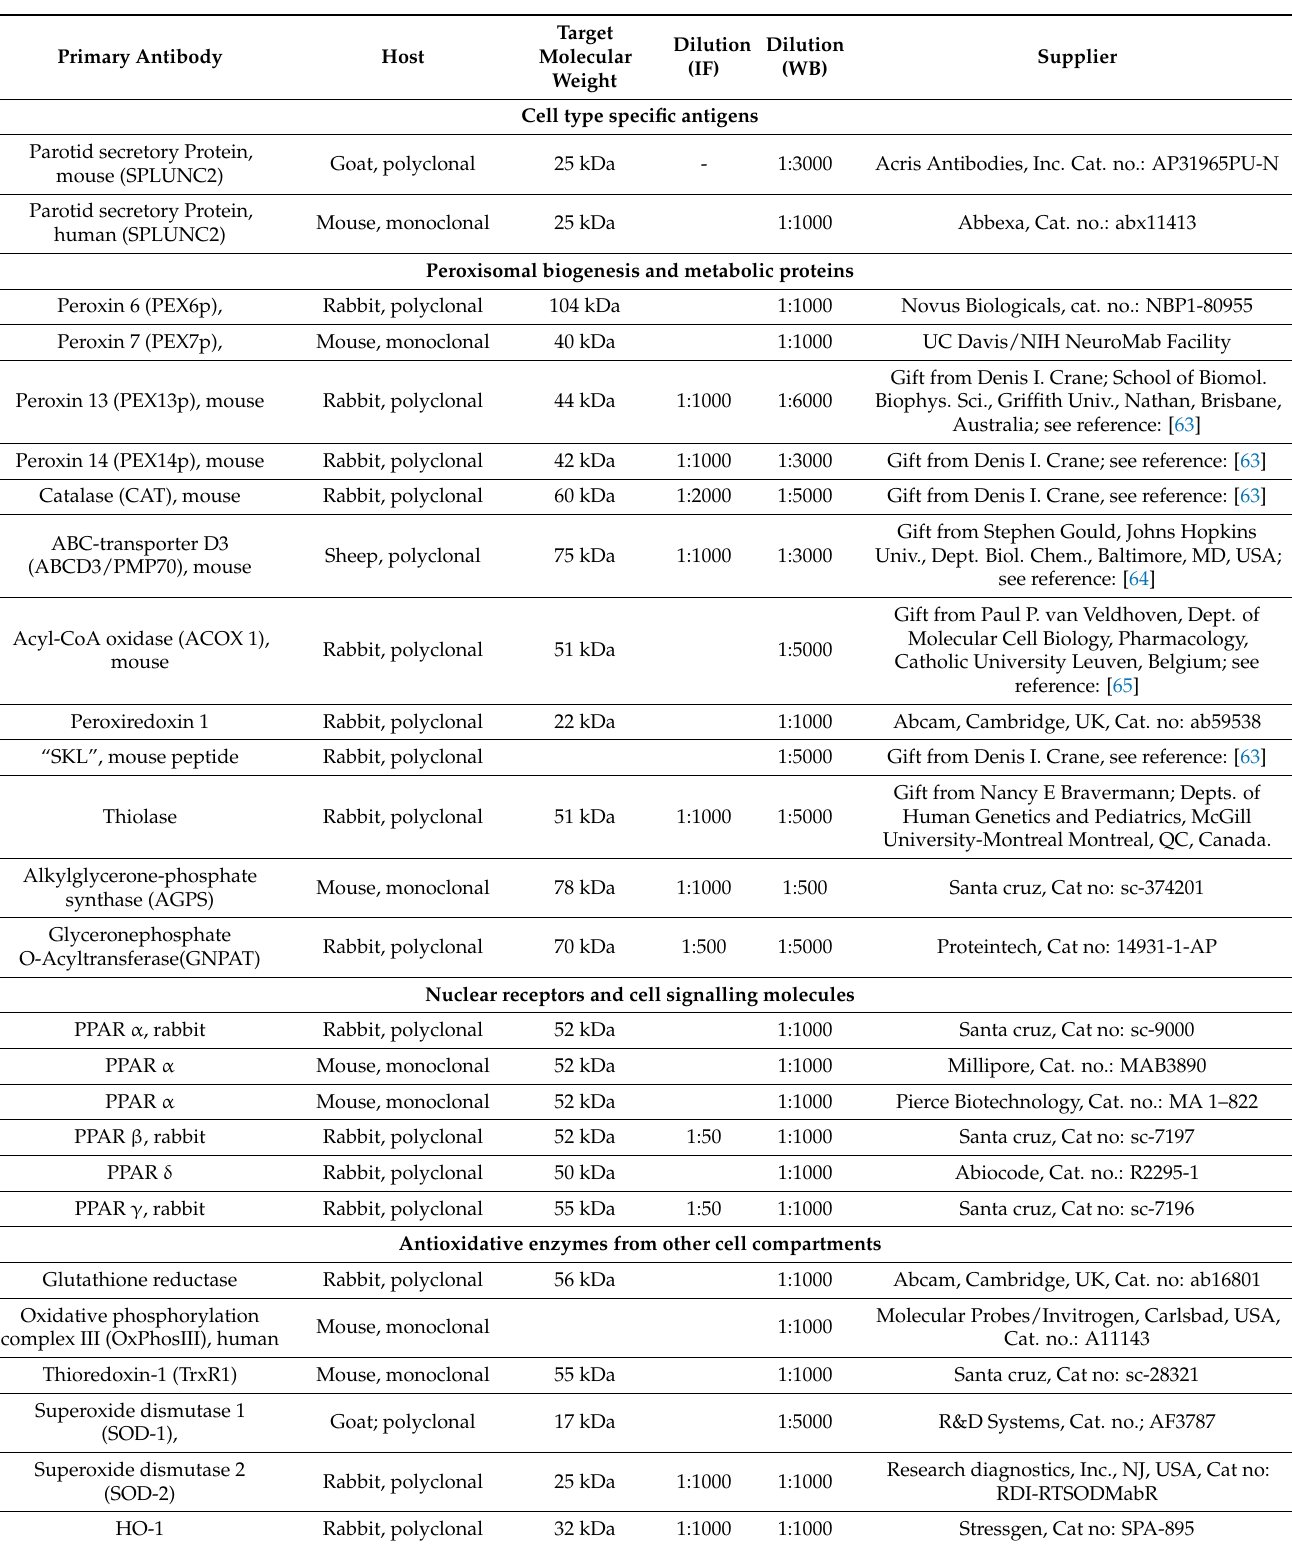
Table 1. List of antibodies used for the detection of peroxisomal proteins in the parotid